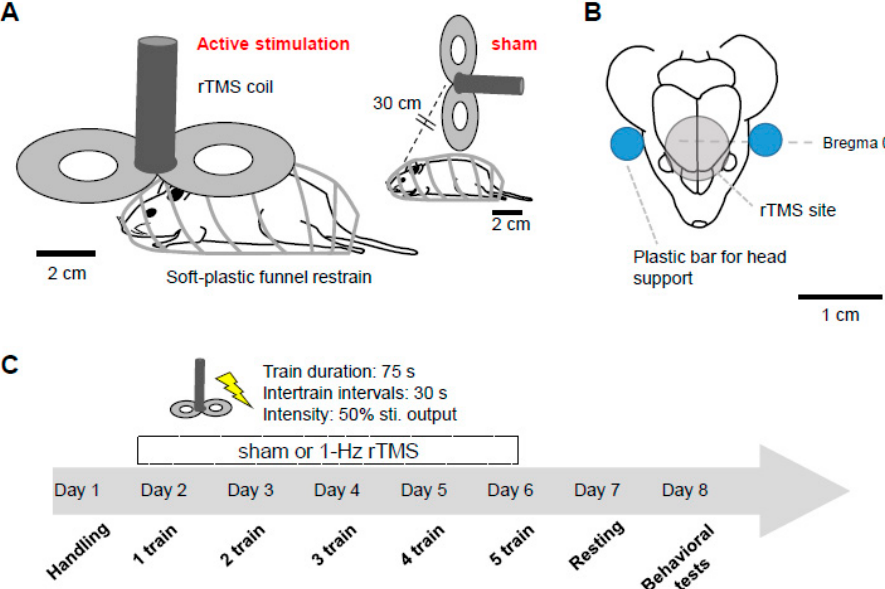
Figure 1. Stimulation procedure and experimental design. ( A ) Schematics of the stimulation procedure showing the awake restrained mouse during stimulation and the stimulated area ( B ). Head movements were minimized by using two plastic bars (right). All the analyses were performed in Sham and 1-Hz rTMS groups after a 5 days stimulation protocol. Behavioral tests were run in a random order twenty-four hours after the final rTMS session. ( C ). 1-Hz rTMS: low-frequency repetitive